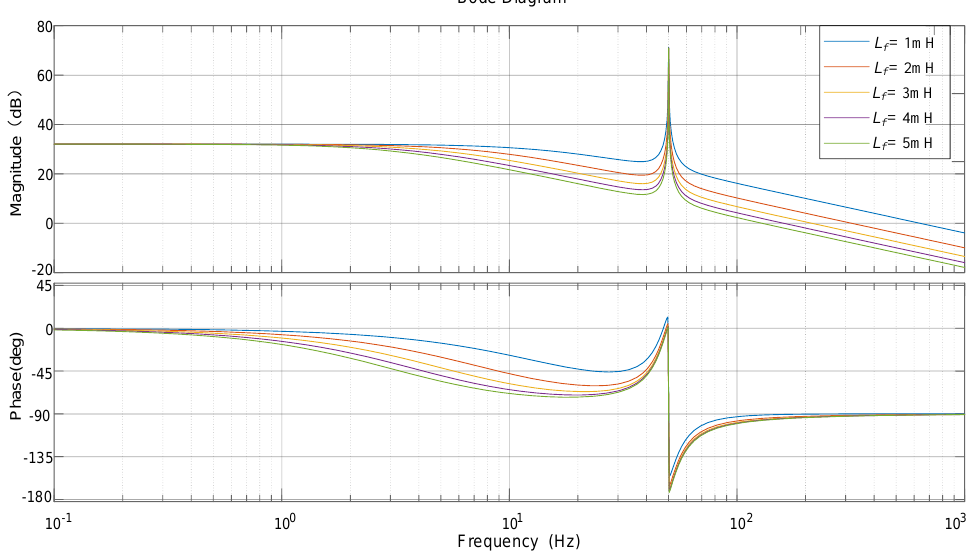
Figure 11. Frequency response considering parameter variation of the